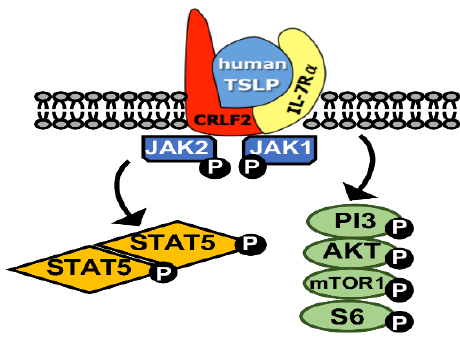
Figure 1. Schematic representation of the CRLF2-receptor complex.